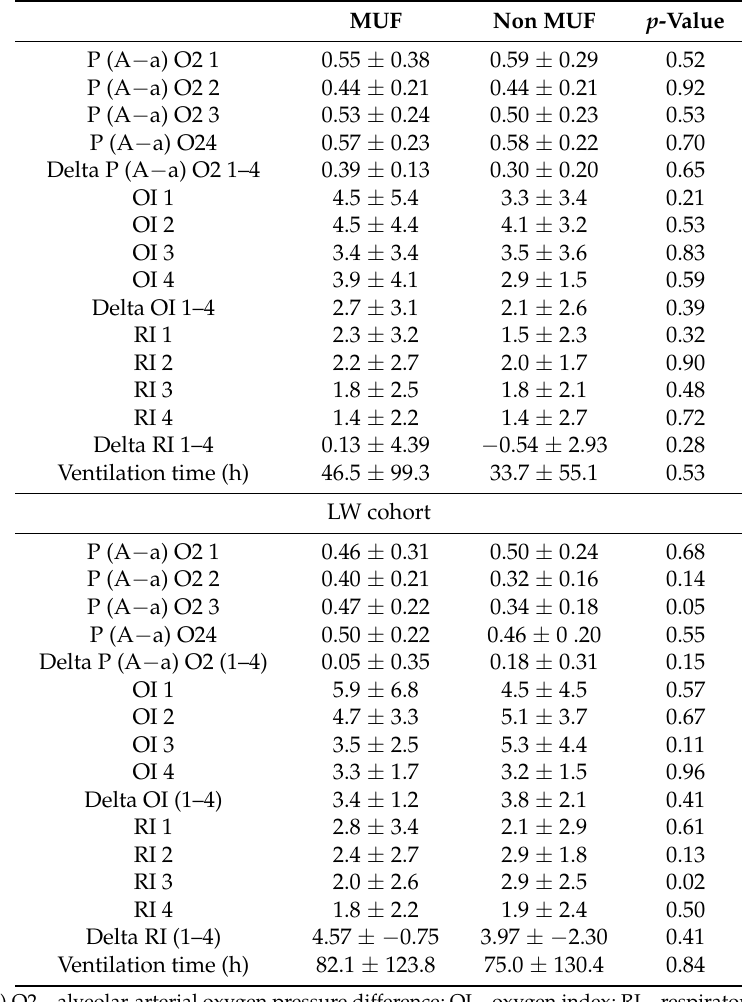
Table 6. Effects on gas exchange capacity and ventilation